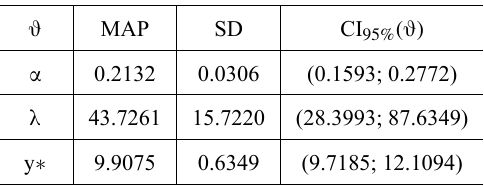
MAPs, SDs and 95% CIs for α , λ and y ∗ related to the WH distribution. θ MAP SD CI 95% ( θ